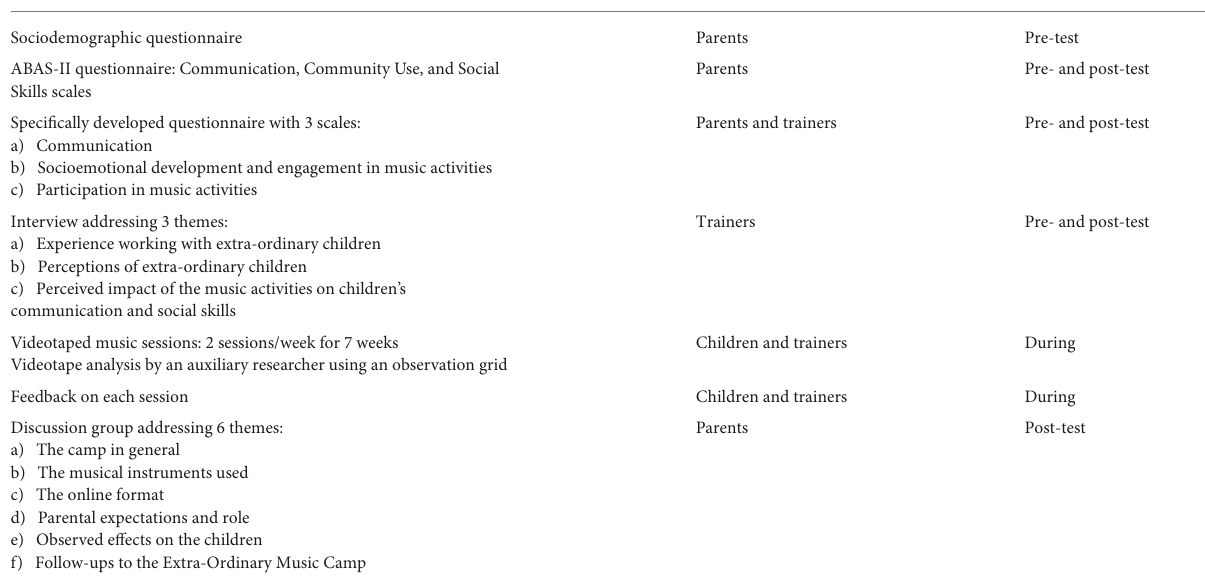
TABLE 2 Measurement